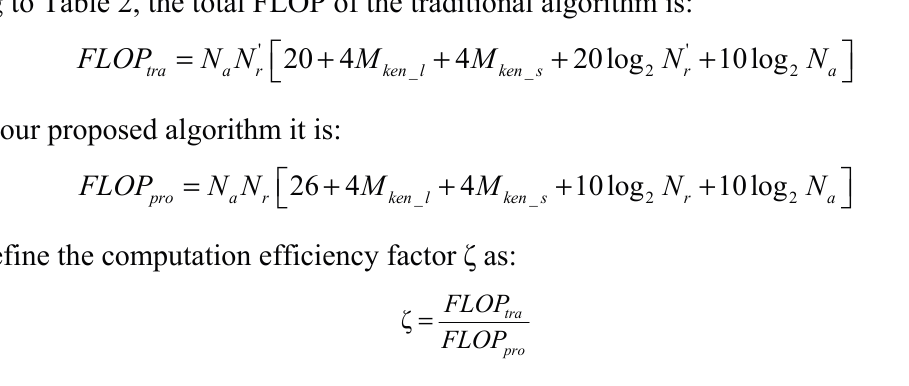
Table 2. Comparison of computational complexity [25]. Traditional